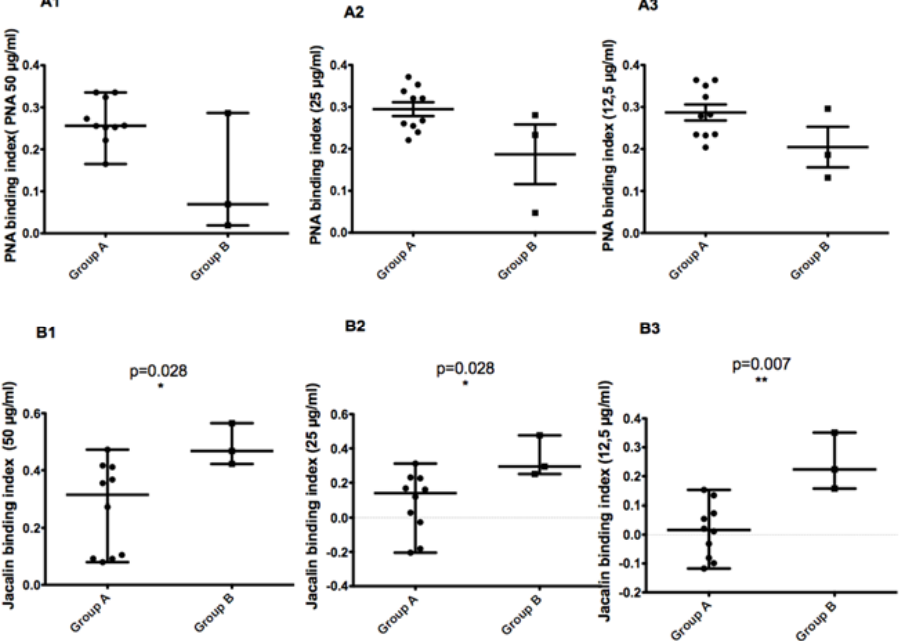
Figure 8. Non-parametric two-tailed Mann–Whitney test measuring the difference in glycoconjugates expression on the promastigote surface between two L. major isolates groups showing different MLMT genetic profiles. The first group of isolates (Group A) is composed of parasites with the 68 bp-71AT. The second group of isolates (Group B) are parasites with the 58 bp-71 AT allele. The binding indices of different PNA lectin concentrations (50, 25, and 12.5 µg/mL) for the promastigotes belonging to the two groups are represented in ( A1 – A3 ), respectively. Binding indices of different Jacalin lectin concentrations (50, 25, and 12.5 µg/mL) for the promastigotes belonging to the two groups are represented in ( B1 – B3 ), respectively. * and ** indicate statistically significant ( p < 0.05), and strongly statistically significant ( p < 0.01) values respectively.